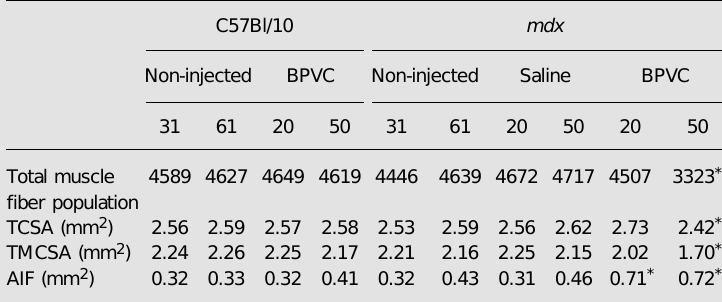
Table 1. Total muscle fiber population, total cross-sectional area (TCSA), total myofiber cross-sectional area (TMCSA) and the area of interstitial fibrosis (AIF) in non-injected and bupivacaine (BPVC)-treated C57Bl/10 and mdx muscles.